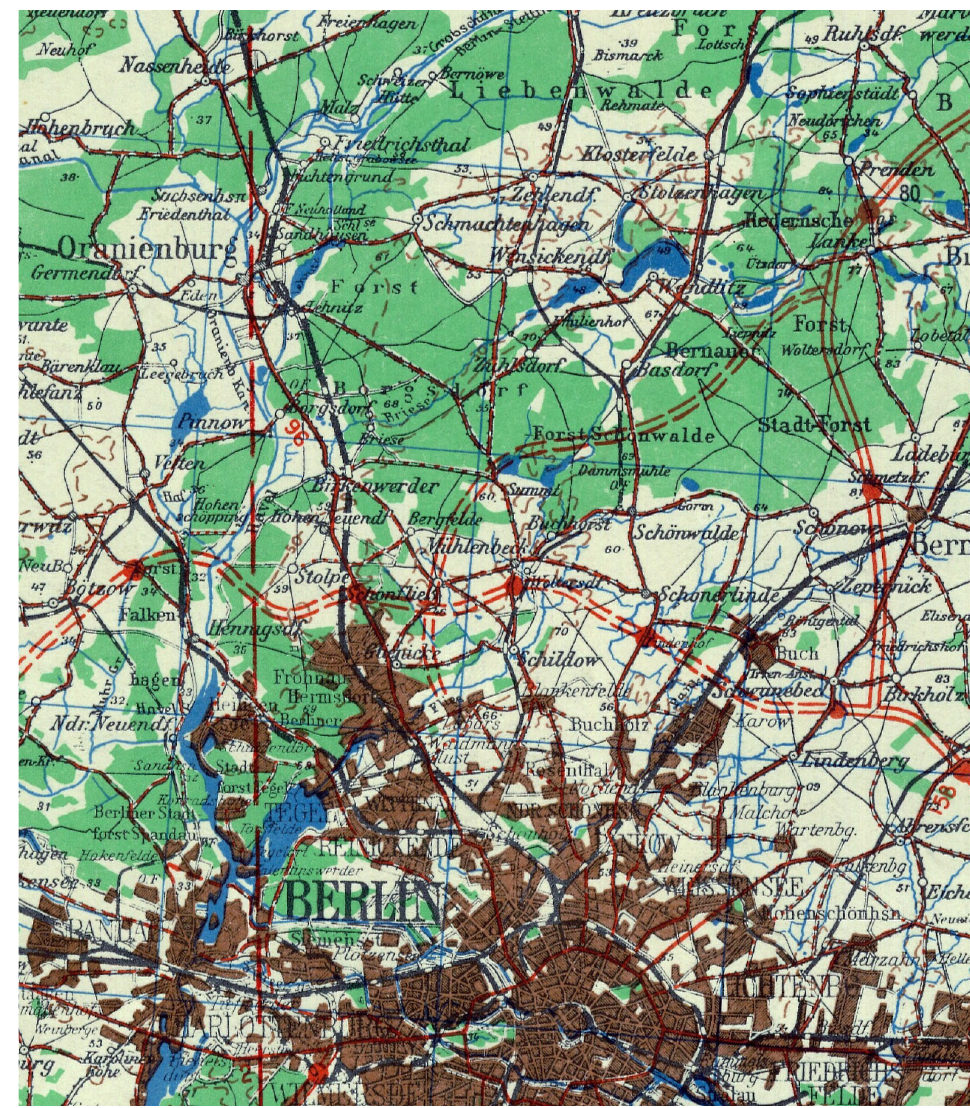
Fig. 4. Part of a British chart from 1943 (published by GSGS) at the scale of 1:250,000 (air and